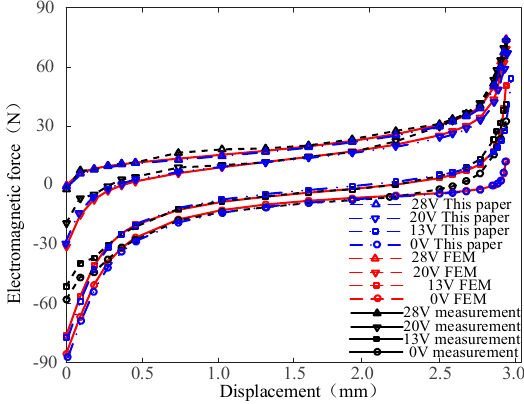
Figure 7. Comparison between measurements and the substitution model.